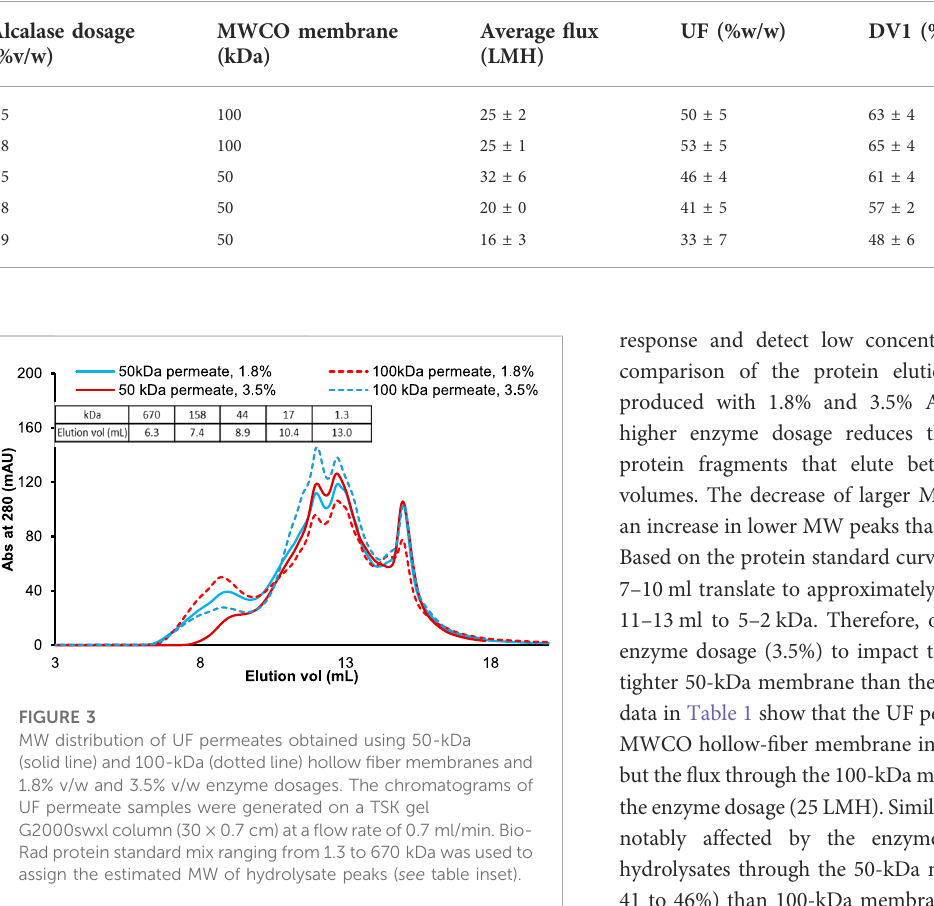
TABLE 1 Impact of the MWCO membrane and enzyme dosage on fl ux and protein recovery in the permeate and after one and two dia fi ltration volume (DV). Cumulative permeate protein yield